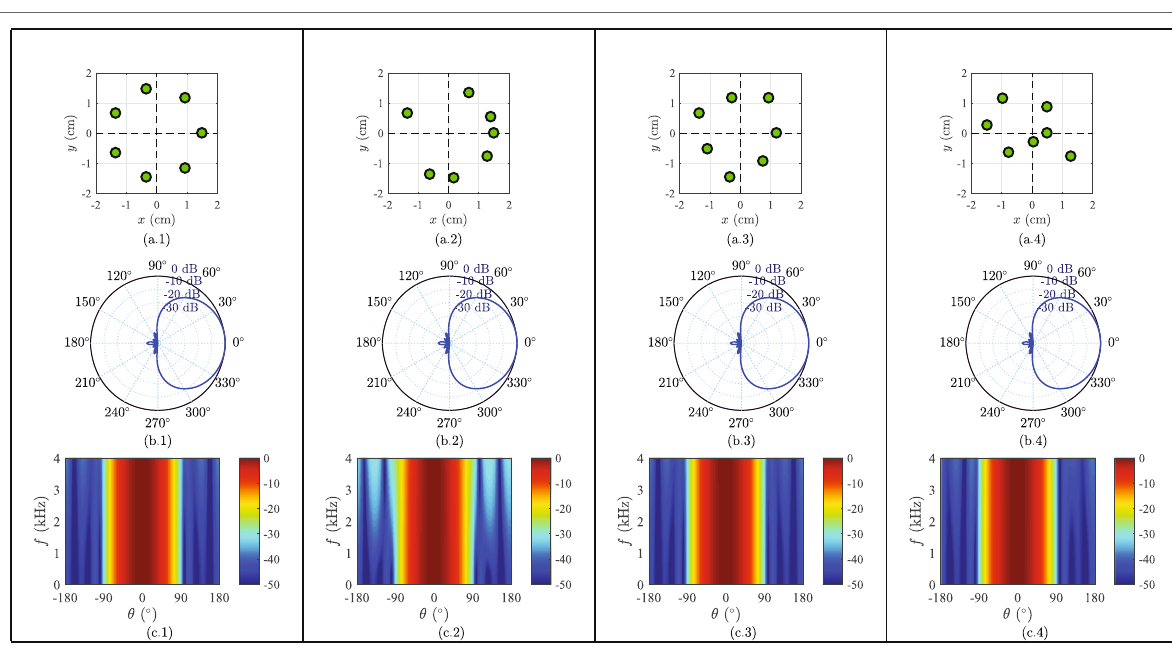
Fig. 8 Array geometries and the corresponding beampatterns of a third-order differential beamformer: a array geometry, b beampatterns at f = 500 Hz, and c broadband beampattern versus